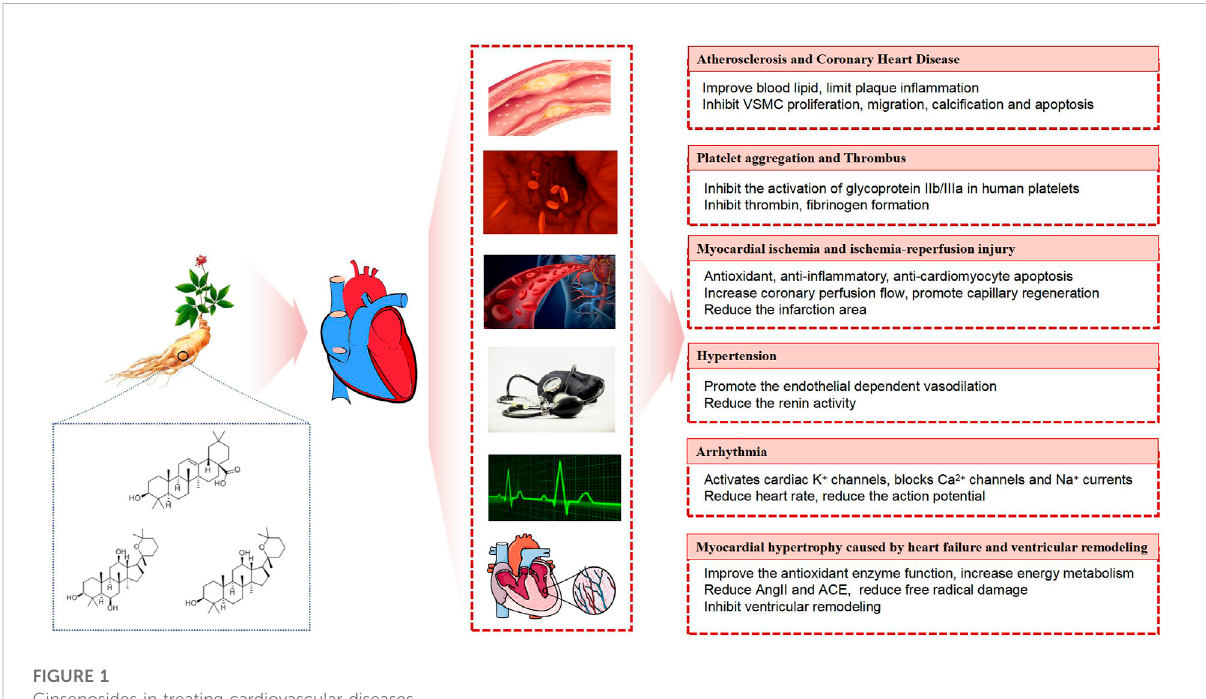
FIGURE 1 Ginsenosides in treating cardiovascular